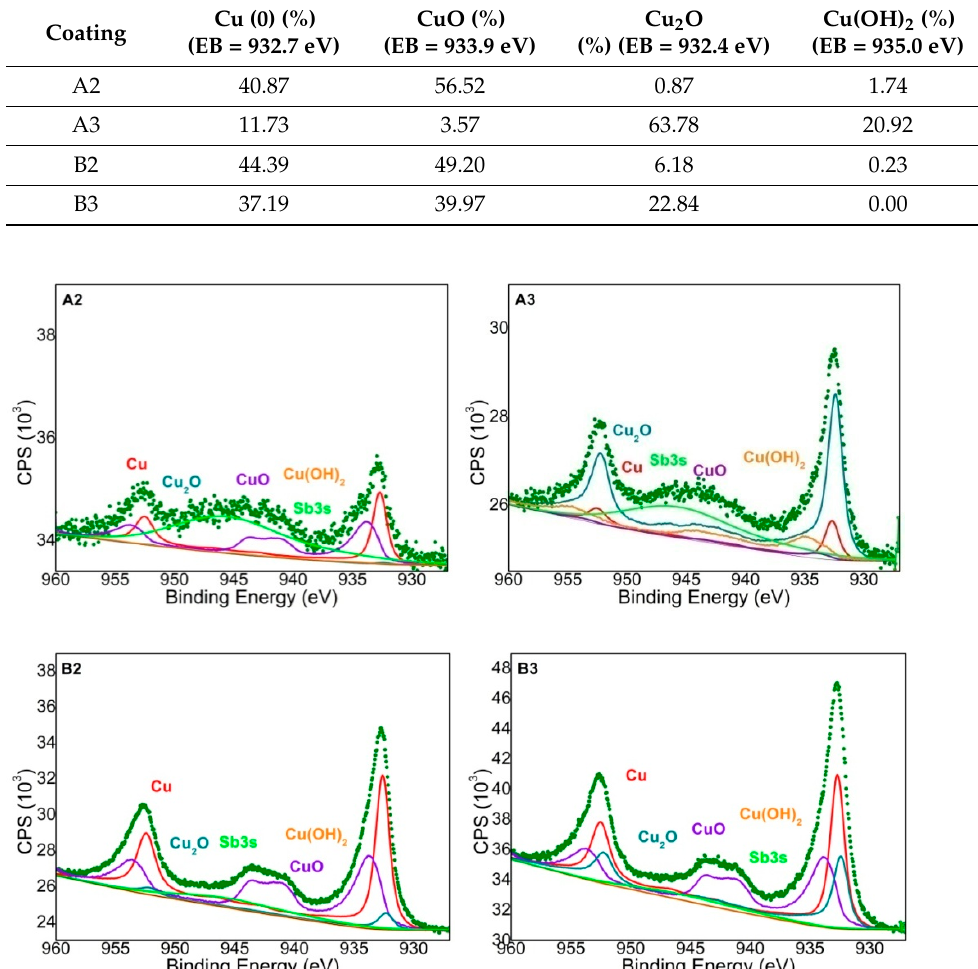
Table 3. Percentage share of various forms of copper in irradiated coatings.